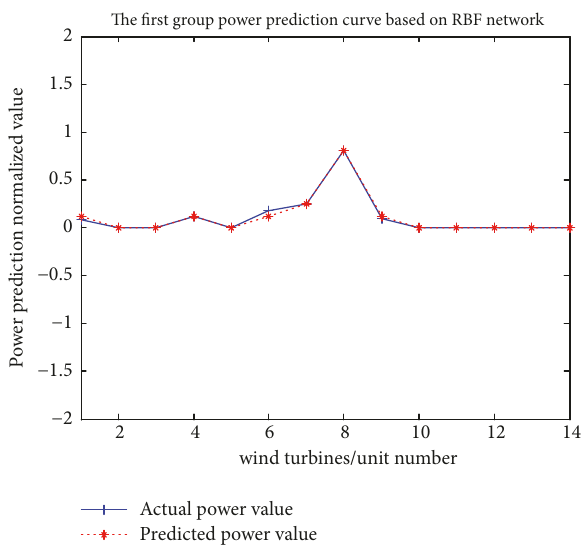
Figure 6: The first group power forecast curve.